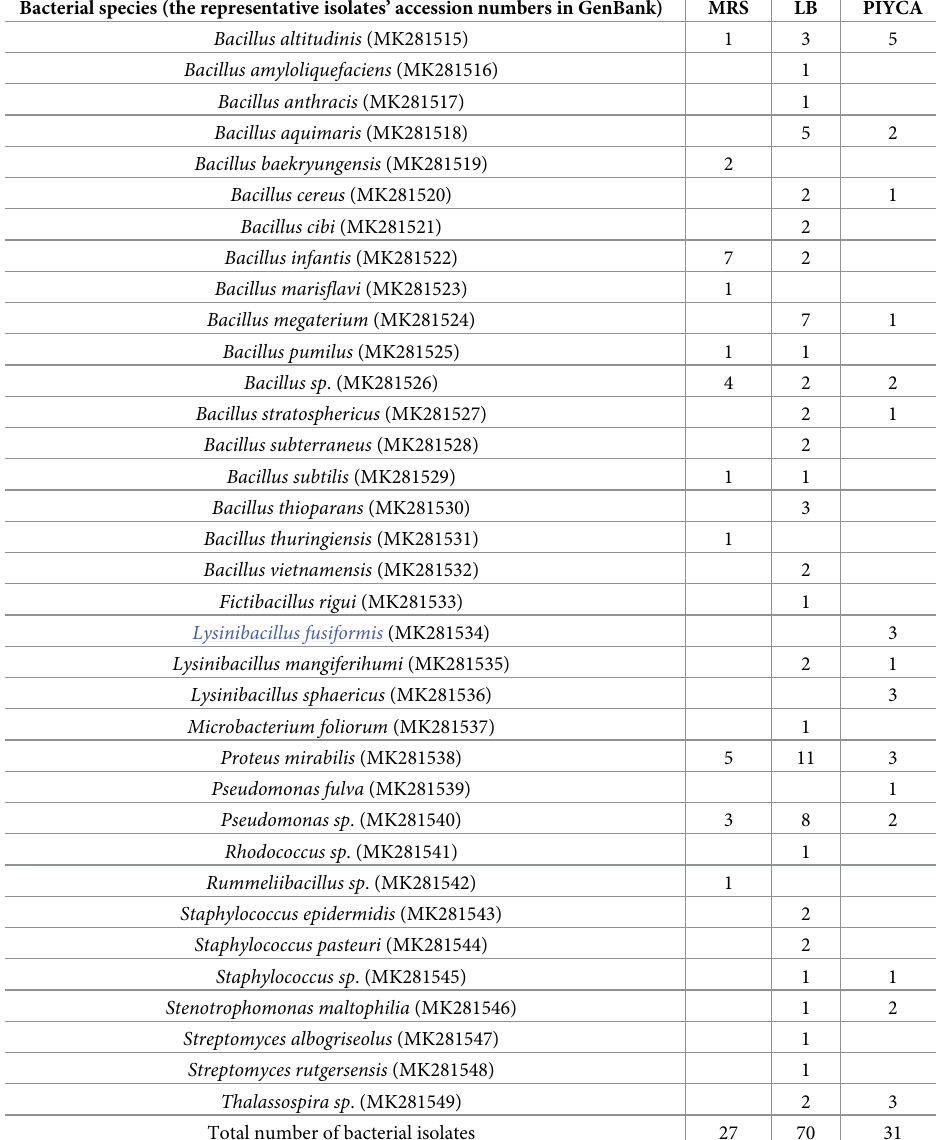
Table 2. The situation of the identified and known bacteria in three different media. Bacterial species (the representative isolates’ accession numbers in